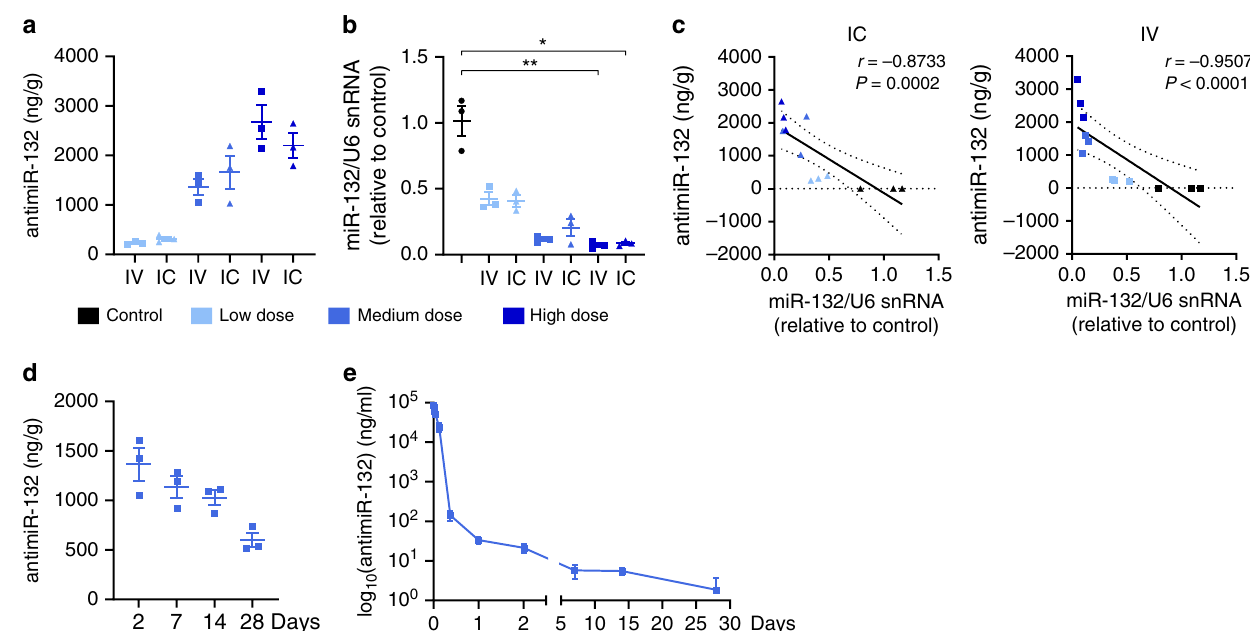
Fig. 3 Pharmacokinetic properties of antimiR-132. a Cardiac tissue levels of antimiR-132 in healthy pigs 48 h post treatment for different dose levels (Control: None; Low = 1 mg/kg, Medium = 5 mg/kg and High = 10 mg/kg antimiR-132, n = 3 respectively) by intravenous (IV) or intracoronary (IC) application. b Functional cardiac tissue level of miR-132 in healthy pigs 48 h post treatment. c Correlation between antimiR-132 and miR-132 cardiac tissue levels in healthy pigs 48 h post treatment. d Time course of cardiac tissue levels of antimiR-132 in healthy pigs at different timepoints post treatment (5 mg/kg antimiR-132, IV, n = 3 respectively). e Plasma levels of circulating antimiR-132 in healthy pigs at different timepoints post treatment (5 mg/kg antimiR-132, IV, n = 3 respectively). Data are mean ± s.e.m; * P < 0.05, ** P < 0.01; Kruskal – Wallis test with Dunn ’ s multiple comparison (Control vs. treatment groups) and linear regression using non ‐ parametric Spearman